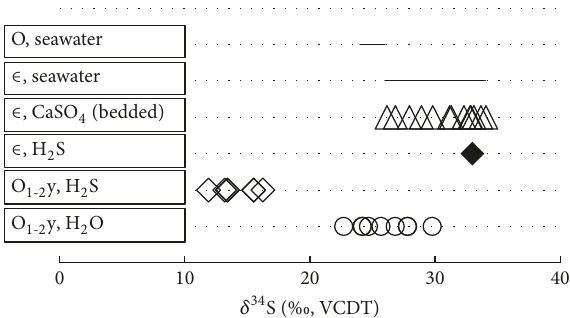
Figure 4: Sulfur isotopic composition of water, H 2 S, and anhydrite. Sulfur isotopic of bedded anhydrite is from Cai et al. [10]. Sulfur isotopic of H 2 S in the Cambrian is from Cai et al.